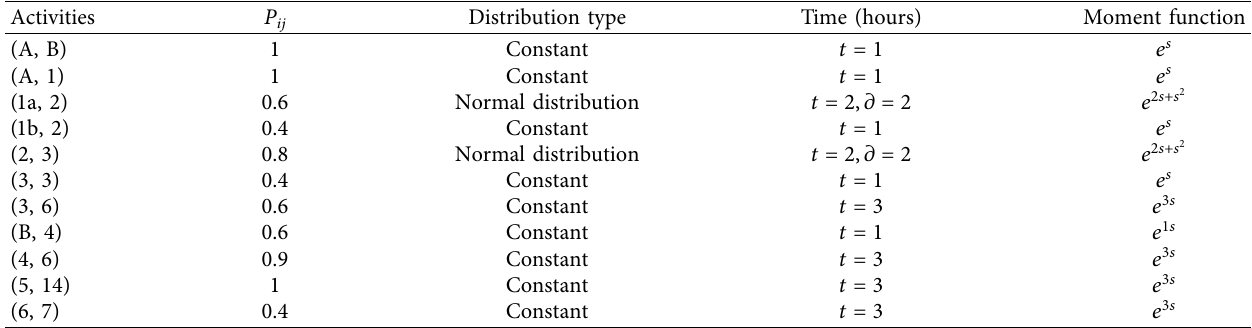
Table 2: GERT random network